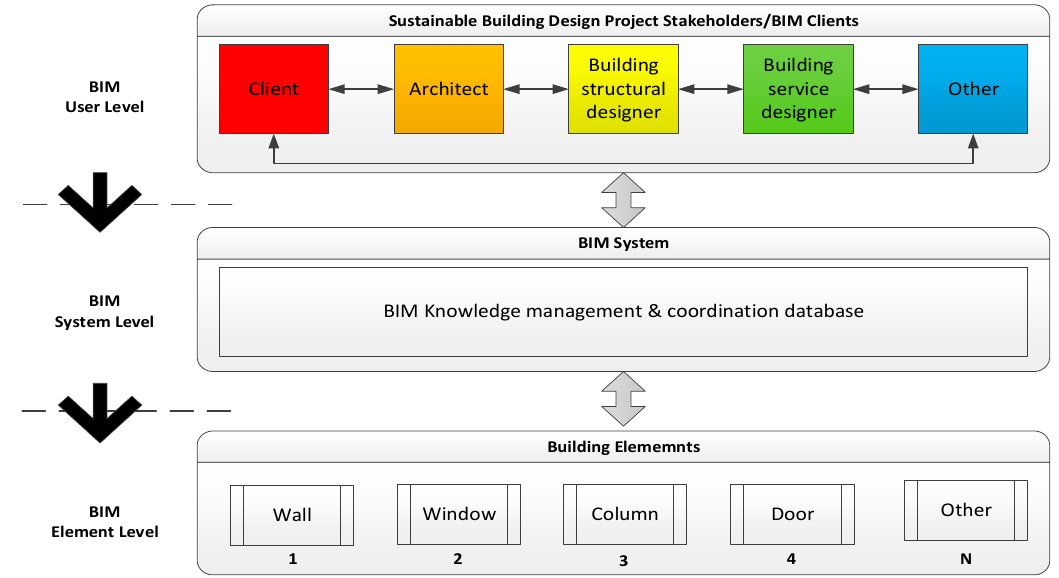
Figure 6. The user level driven BIM system for sustainable building design in information management of building construction project management (devised by the authors).